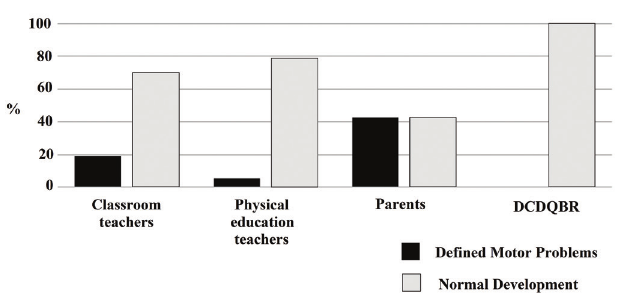
Figure 1. Classification of the children’s motor development using the MABC-2 Checklist according to the DCDQBR.